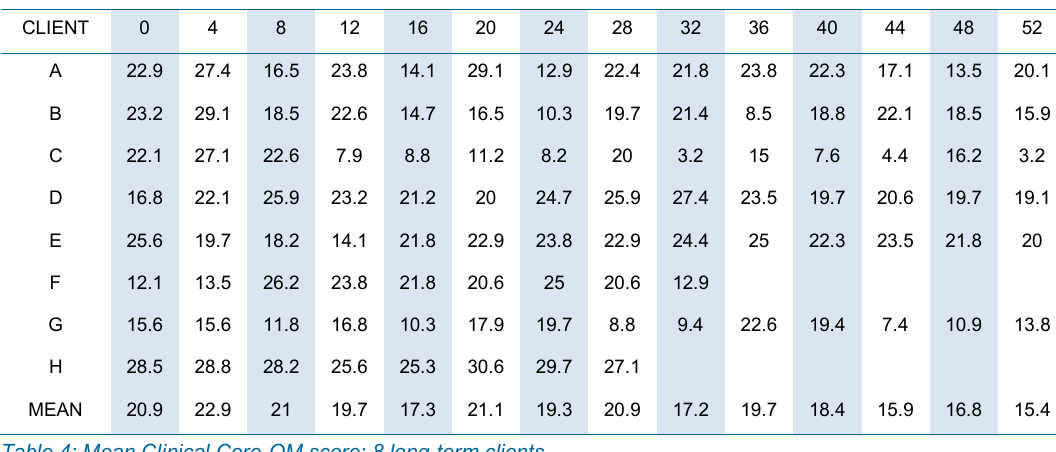
Table 4: Mean Clinical Core-OM score: 8 long-term clients